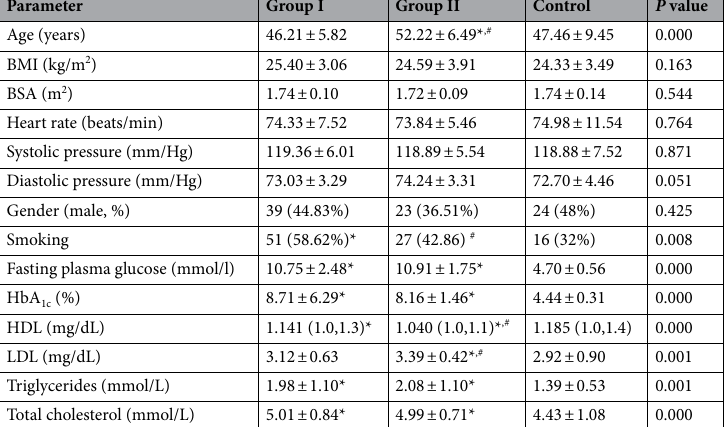
and E/e’ was higher than control and group I ( P < 0.05). LVEF was higher in group II than in control ( P < 0.05) (Table 2). Comparison of strain parameters. There was no statistically significant difference between the groups in the circumferential strain evaluated at the basal left ventricular level (SAXBCS) and the global left ventricular circumferential strain (LVGCS) ( P > 0.05). LVGLS, longitudinal strain of the left ventricle in apical two-chamber view (LVAP2LS), longitudinal strain of the left ventricle in apical three-chamber view (LVAP3LS), longitudinal strain of the left ventricle in apical four-chamber view (LVAP4LS), and 2D-GLS in group I were significantly lower than those in the control group ( P < 0.05). LVGLS, LVAP2LS, LVAP3LS, LVAP4LS, and 2D-GLS in group II were significantly lower than those in control and group I ( P < 0.05). Circumferential strain measured at the basal left ventricular level (SAXMCS) and circumferential strain measured at the apical left ventricular level (SAXACS) were lower in group II than in the control group ( P < 0.05). The differences between groups for the remaining parameters were not statistically significant (Table 3). Comparison of TMAD parameters, MAPSE parameters and s’. and MAPSE-mean were significantly lower in group I than in the control group ( P < 0.05). AP4MV1, AP4MV Midpt, AP2MV1, AP2MV2, AP2MV Midpt, AP2MV Midpt%, s’, MAPSE-SEPTAL, MAPSE-LATERAL, and MAPSE-mean were significantly lower in group II than in group I and the control group ( P < 0.05). Both AP4MV2 and AP4MV Midpt% were lower in group II than in the control group ( P < 0.05) (Table 4). Repeatability test. The intra- and inter-observer agreement was high for LVGLS, AP4MV1, s’, MAPSE- mean, and 2D-GLS (Fig. 1).